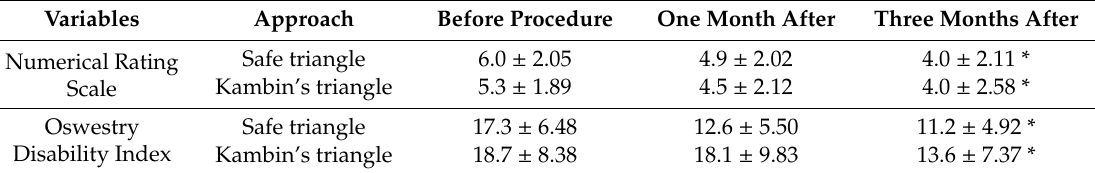
Table 3. Comparison of Numerical Rating Scale score and Oswestry Disability Index score before and after the procedure in the safe-triangle-approach and Kambin’s-triangle-approach groups.